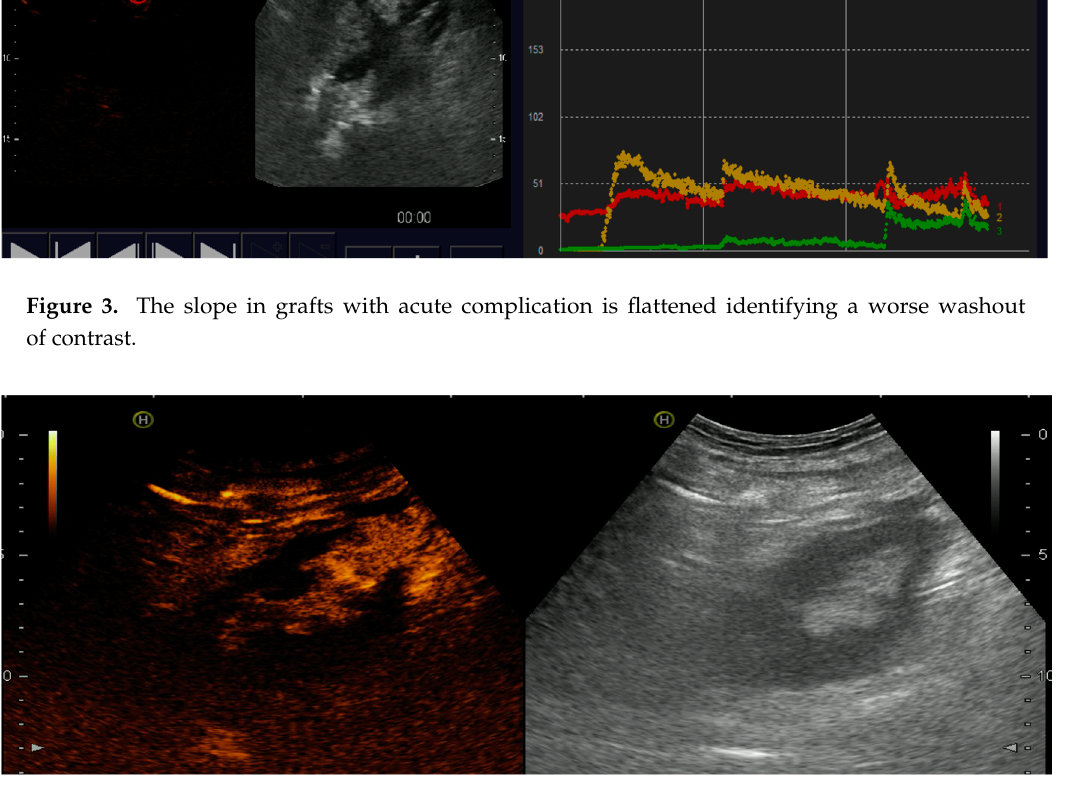
Figure 4. Partial absence of contrast-enhancement at the upper pole showing a focal ischemia secondary to a polar artery thrombosis.